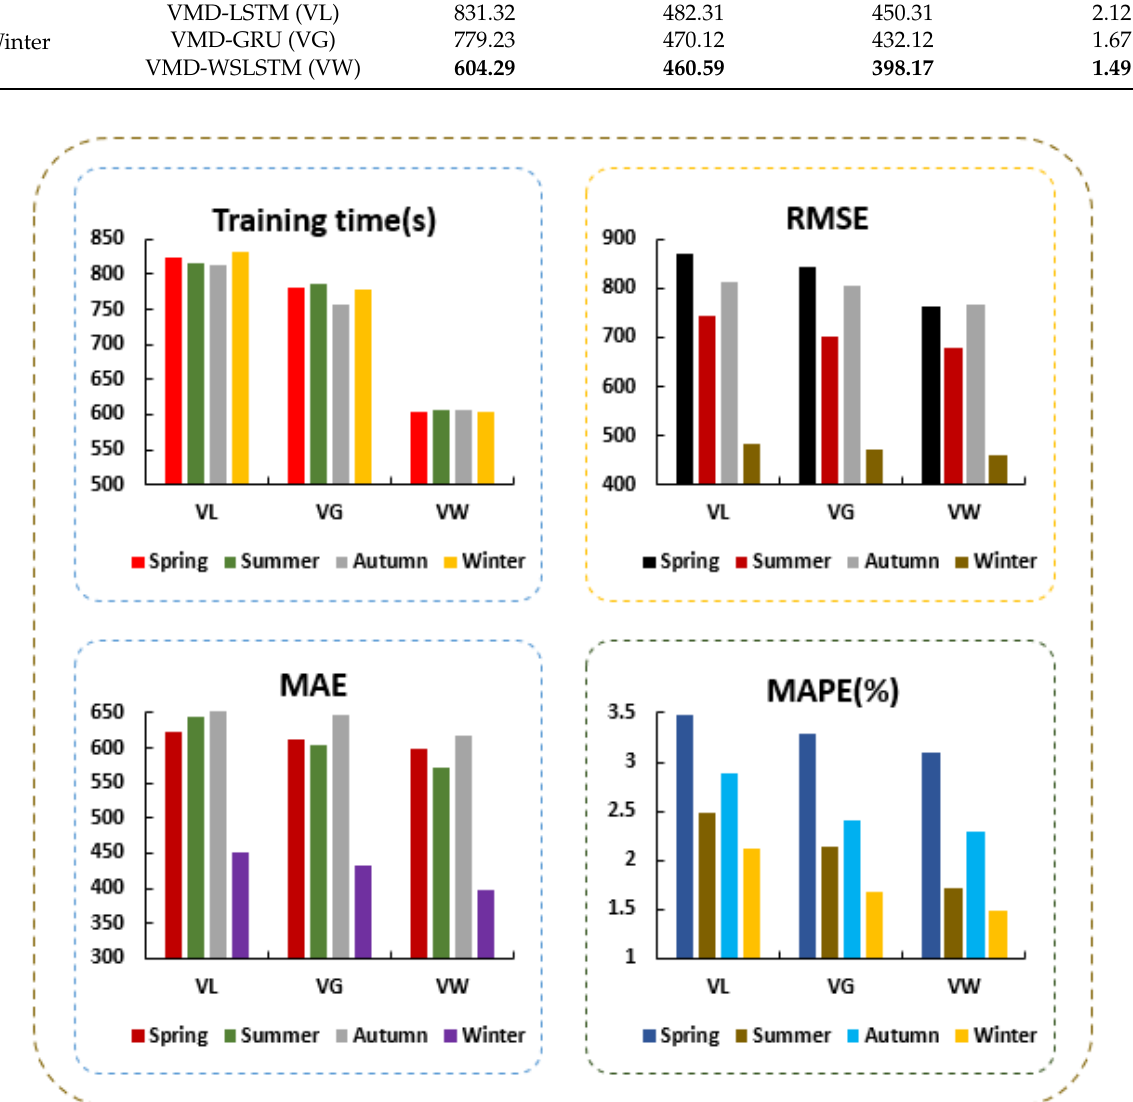
Figure 9. Forecast results of different forecasting methods.